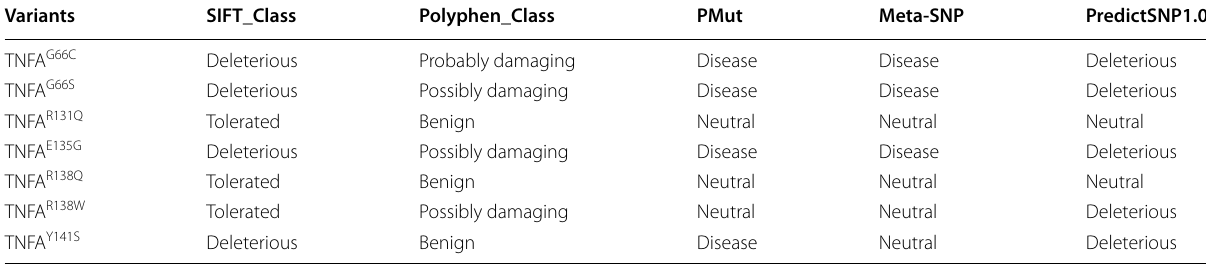
Table 7 Predicted pathogenicity of the selected variants